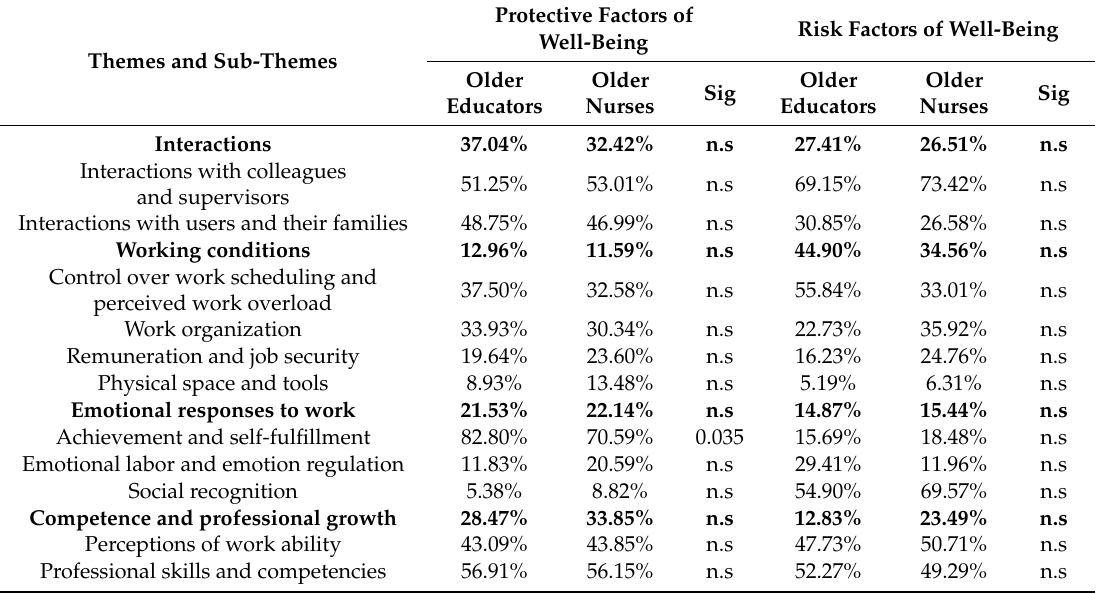
Table 4. Risk and protective factors of well-being at work: data comparison between older educators and older